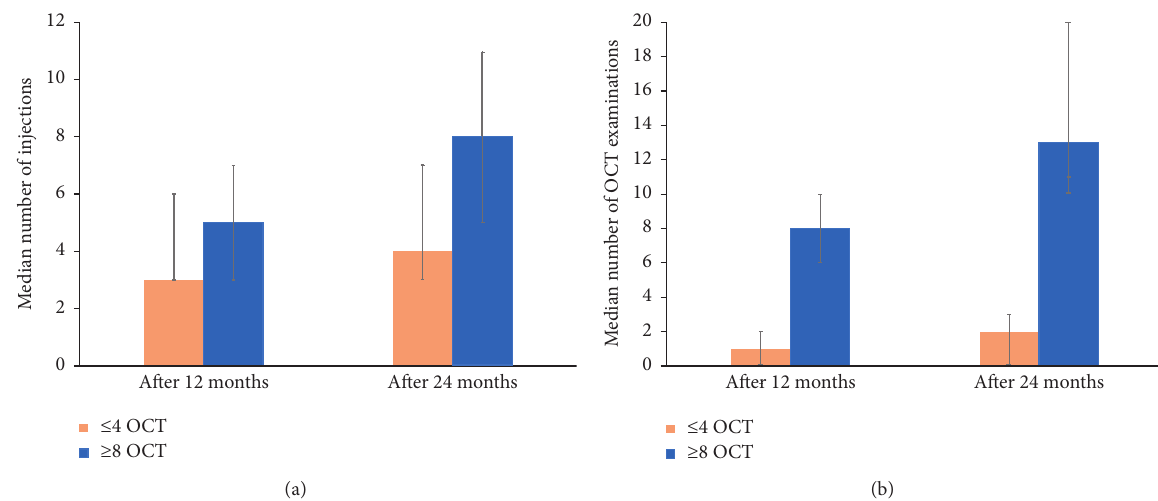
Figure 3: (a) Median number of ranibizumab injections with the first and third quartiles for patients receiving ≤ 4 OCTexaminations or ≥ 8 OCT examinations for the matched sample ( N � 411 for both groups); (b) median number of OCT examinations with the first and third quartiles for patients receiving ≤ 4 OCT examinations or ≥ 8 OCT examinations for the matched sample ( N � 411 for both groups). OCT: optical coherence tomography.